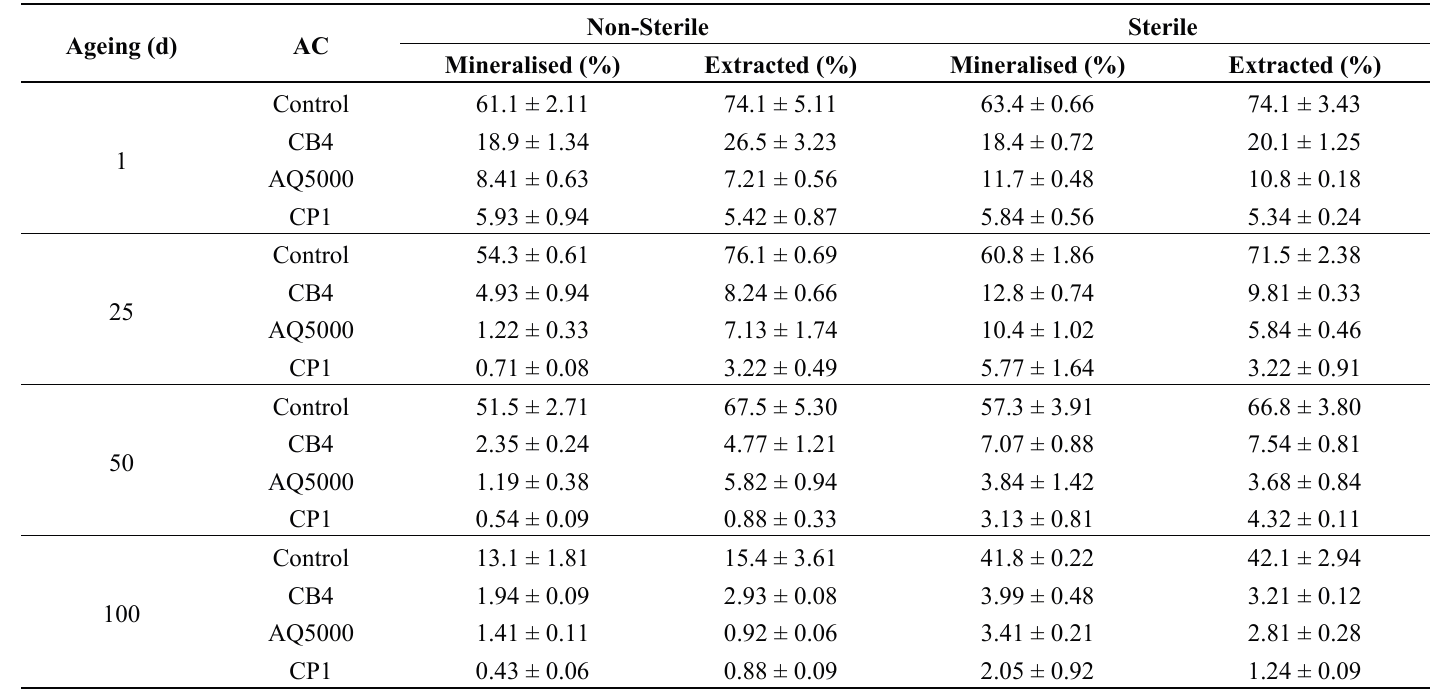
Table 3. 14 C-Phenanthrene extracted by hydroxypropyl- β -cyclodextrin (HPCD) (after 22 h) and 14 C-phenanthrene mineralised in non-sterile and sterile soils. Values are mean ± standard error ( n =